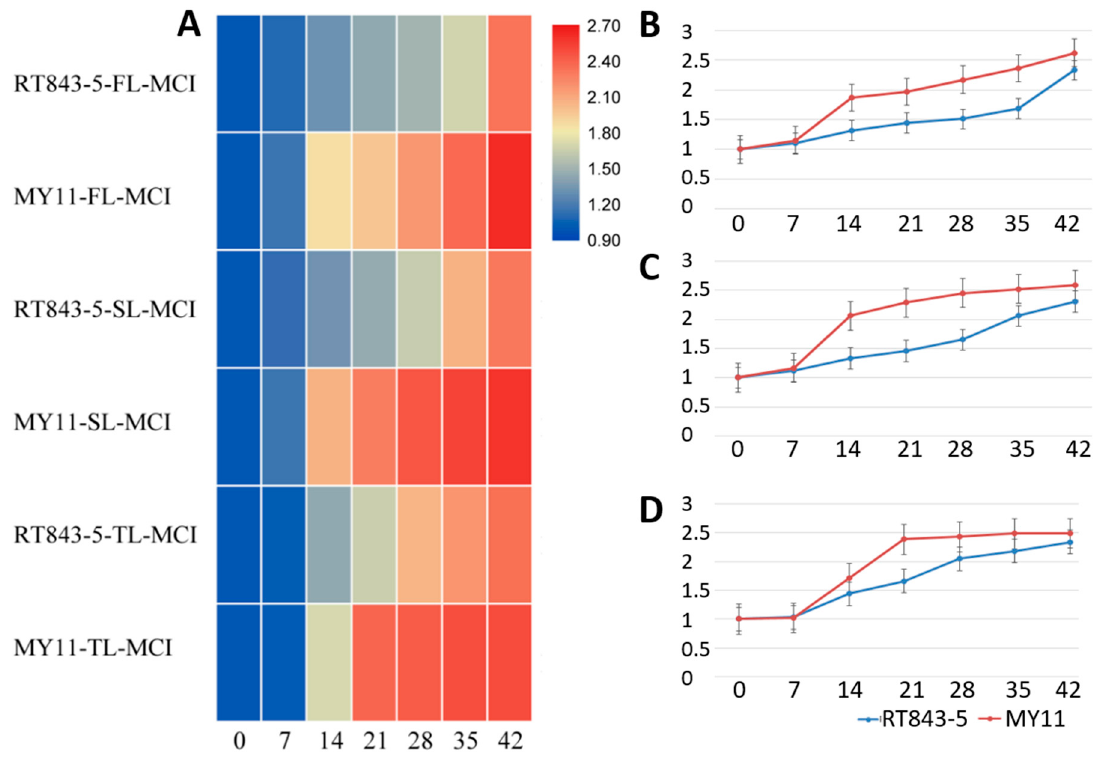
Figure 8. Differences in the MCI (MDA content index) between RT843-5 and MY11 during leaf senescence after anthesis. ( A ): Heatmap of the changes in the MCI in the FL, SL, and TL. The different colors show the different values of MCI. ( B ): The change curve of the MCI of the FL; ( C ): The change curve of the MCI of the SL; ( D ): The change curve of the MCI of the TL. The Y-axis shows the values of the MCI, and the numbers on the X-axis show the days after anthesis.